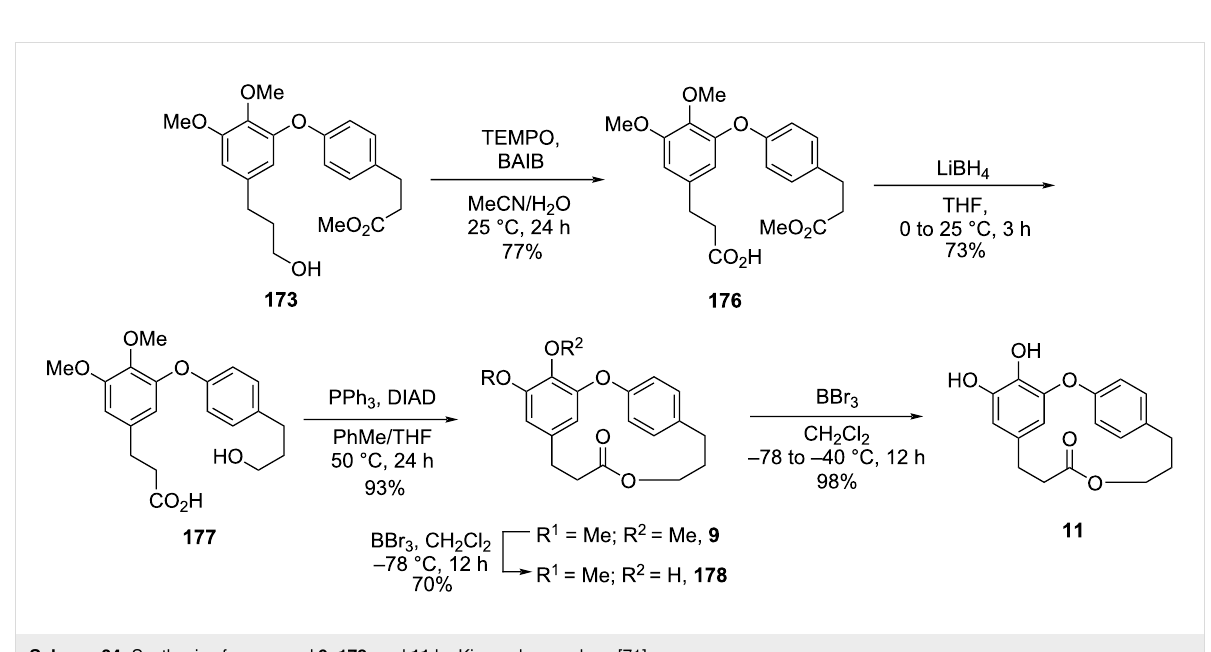
Scheme 34: Synthesis of compound 9 , 178 , and 11 by Kim and co-workers